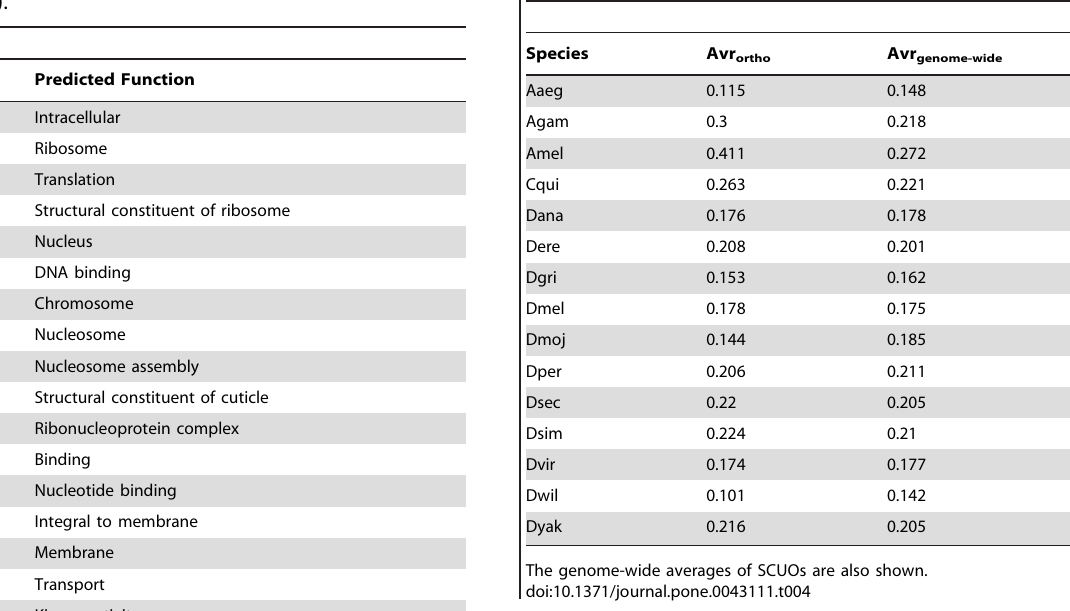
Table 4. Average synonymous codon usage orders (SCUOs) of orthologous